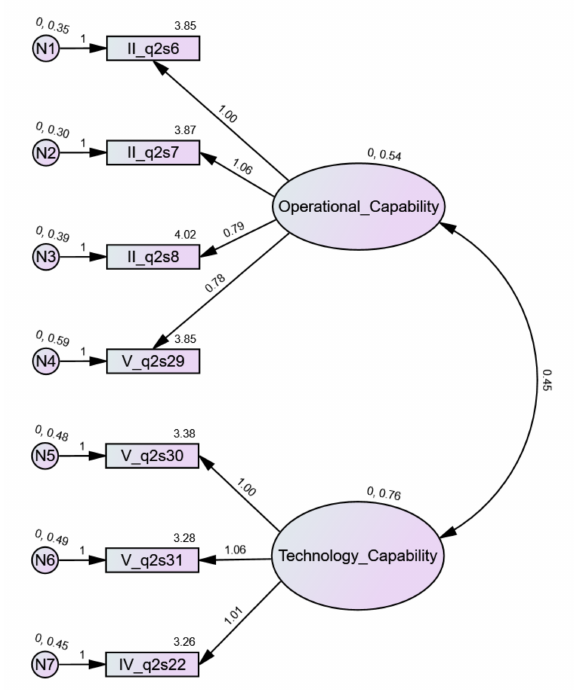
Figure 6. CFA model of organizational e-readiness (unstandardized estimates).